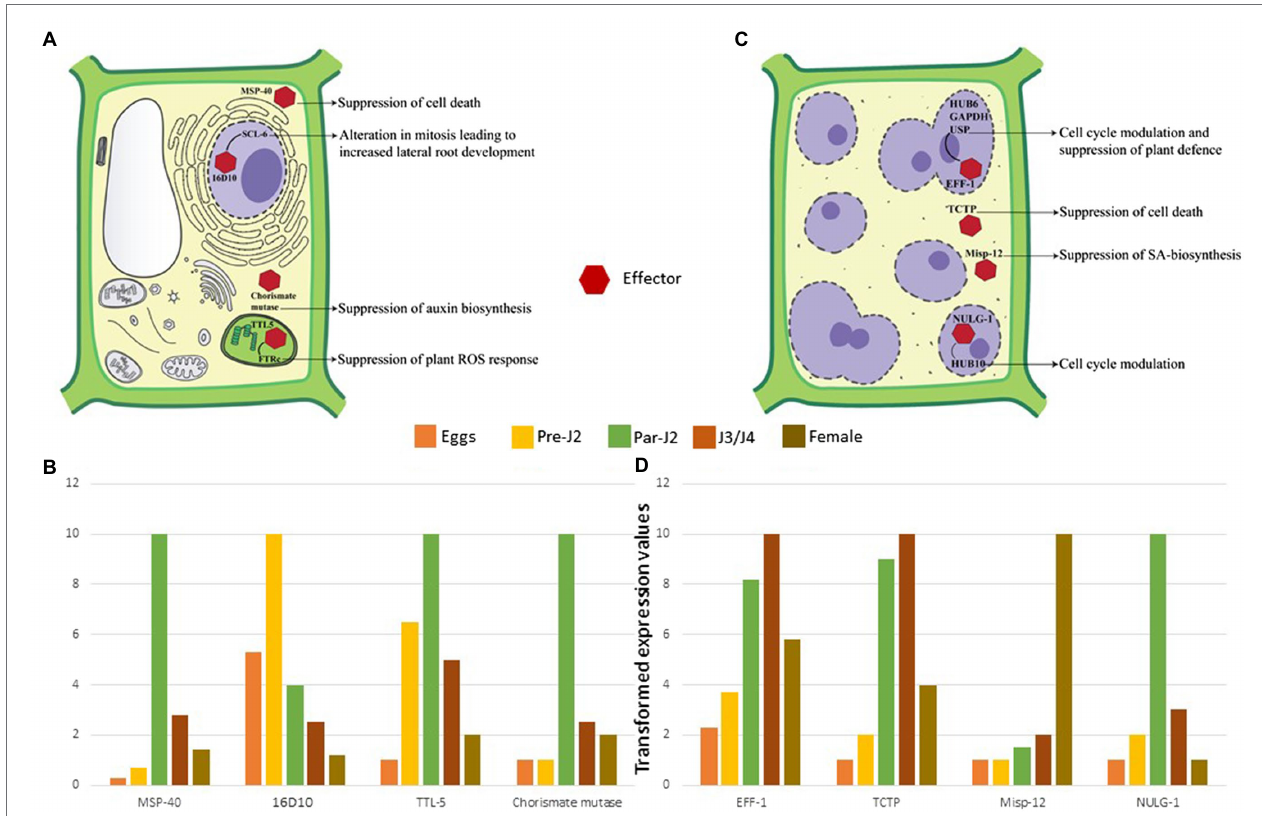
FIGURE 4 | Molecular effects of RKN effectors (A) Parasitic juveniles produce effectors in SvGs which modulates plant defence response and cell cycle allowing the formation of GCs. The effectors secreted by parasitic juveniles (shown by red hexagon) target various cellular components and pathways of plants. In the cytoplasm MSP-40 and chorismate mutase suppress the cell death and auxin biosynthesis, respectively. In the plastids, TTL-5 interacts with plant FTRc suppressing the plant ROS response. In the nucleus MSP-16 interacts with plant SCL-6. These interactions result in alteration of mitotic cell division and alternative splicing. (B) The expression dynamics reveals that these effectors are produced pre-parasitic and parasitic J2s. Real-time expression data from various articles is used to generate the illustrative patterns of effector gene expression across the different stages of RKN (Huang et al., 2005b, 2006b; Lin et al., 2016; Niu et al., 2016). The maximum expression for a given effector in a particular life-stage is considered as 10. Accordingly, expression at remaining life-stages is calculated which is less than 10. The bars depict these transformed values. Since, these are transformed values from different data sets, it is not possible to give error bars in this case. (C) Adult sedentary RKNs produce effectors in DG that help in maintaining GCs throughout the parasitism. Eff-1 interacts with multiple plant proteins in the nucleus leading to cell cycle modulation and RNA instability. Similarly, NULG-1 targeted to the nuclei also help in cell cycle modulation. In the cytoplasm, TCTP and Misp-12 suppress the cell death and salicylic acid biosynthesis, respectively. These effectors and various others help in GC maintenance by suppression of cell death, plant defence response, and cell cycle modulation. (D) The expression profile suggests their maximum expression in J3/J4 and adult stages only. Real-time expression data from various articles is used to generate the graph (Xie et al., 2016; Zhuo et al., 2017; Godinho Mendes et al., 2021a,b). The maximum expression for a given effector in a particular life-stage is considered as 10. Accordingly, expression at remaining life-stages is calculated which is less than 10. The bars depict these transformed values. Since, these are transformed values are from different data sets, it is not possible to give error bars in this